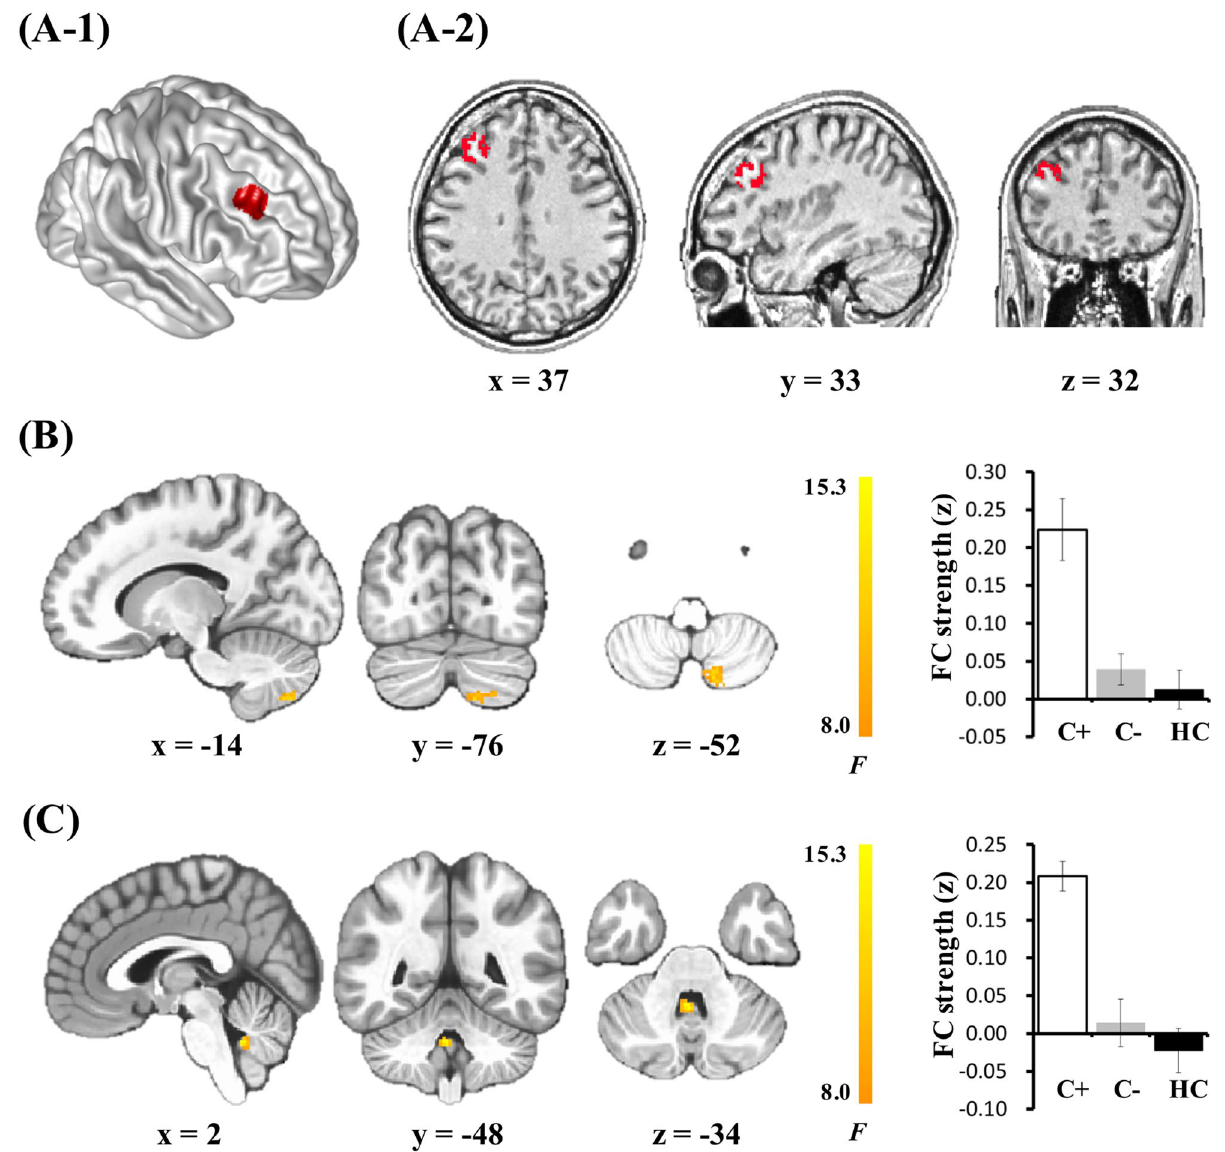
Figure 1. Group analysis results for FC of the right DLPFC. ( A ) The seed ROI in the right DLPFC ( A-1 ) and its example on T1-weighted MRI of individual subject ( A-2 ). The breast cancer patients treated with chemotherapy showed increased FC compared to control groups between the seed region of the right DLPFC and the left cerebellar lobule VII ( B ) and the cerebellar vermis XI ( C ). Brain maps of results of ANCOVA were superimposed on the MNI152 T1 template. The bar graph shows the average FC strength with the right DLPFC in the regions showing significant differences among groups. FC functional connectivity, DLPFC dorsolateral prefrontal cortex.